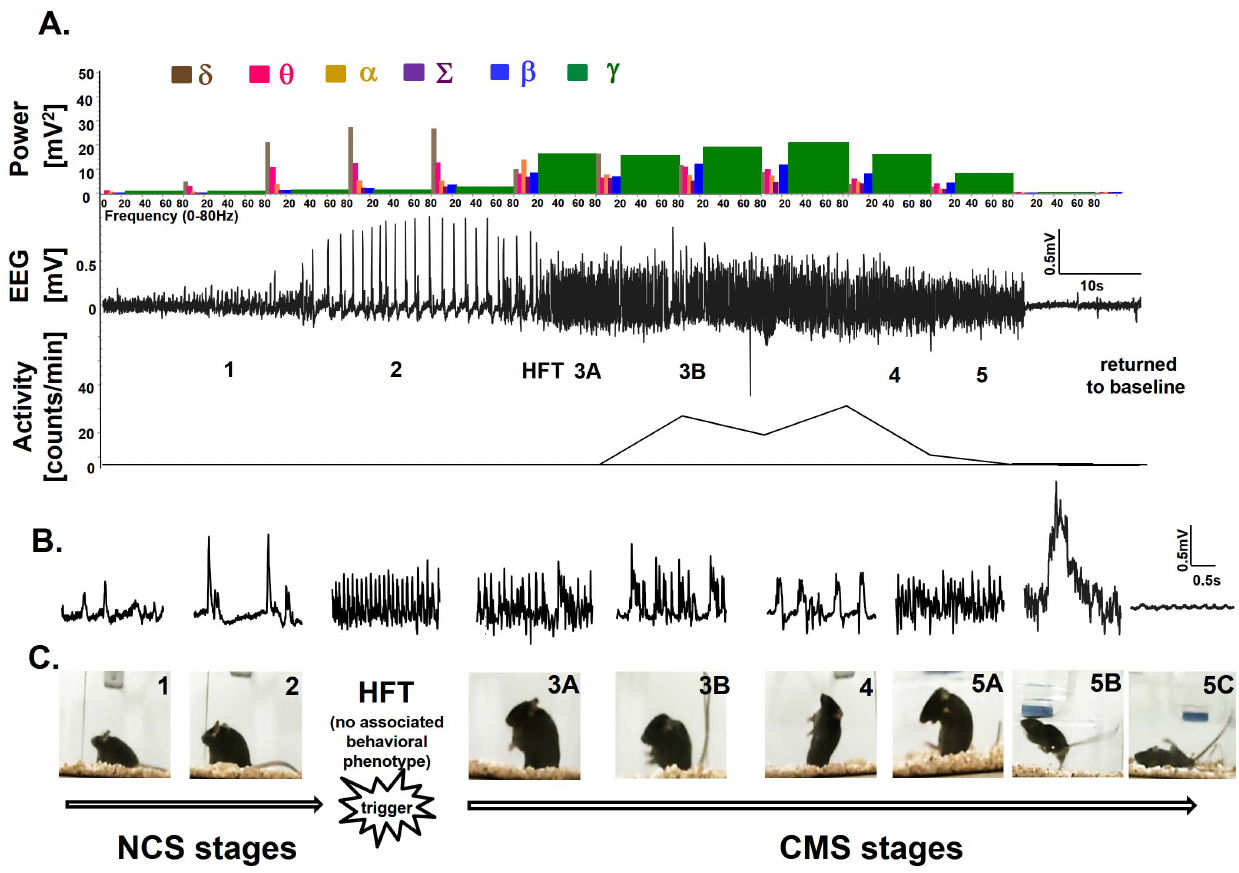
Figure 5. An example of an EEG trace (for 2 min) showing different stages of seizure episodes, induced by KA in C57BL/6J mouse, correlating with power spectrum, activity level and real-time behavioral seizures captured from video-EEG recording. A: EEG trace in the middle shows changes in the electrical activity as the seizure severity progressed from NCS to CMS over time. A brief HFT on the EEG, which had no behavioral counterpart, preceded the CMS. Different stages of behavioral seizures are shown by photographs (C). Magnified 2 second traces (B) representing EEG signatures for each stage of behavioral seizure. The histograms at the top panel in ‘A’ represent power bands. The baseline power of all bands was less than 5 mV 2 and the amplitude of the baseline was , 200 m V. As the seizure progressed from NCS to CMS, the power bands, and especially gamma power, increased (shown in green). Gamma power band increased after HFT, peaked at stage-3B, and started declining in stage-4 and -5 before returning to the baseline. Activity counts (per min), shown below the EEG trace, increased from stage-3A onwards and peaked in stage- 3B and -4. Activity counts reduced in stage-5 when the mice were recumbent or showed generalized rigidity but, increased when the mice displayed jumping behavior. A higher delta band was found to be the hallmark of stage-2 seizures. Reduction in the peaked delta band was characteristic when NCS progressed to CMS. HFT was characterized by a peak of alpha and sigma bands. A transient increase in theta band marked the transition from stage-3A to -3B. Gamma and beta bands peaked in stage-3B and declined slowly in stage-4 and -5 before reaching the